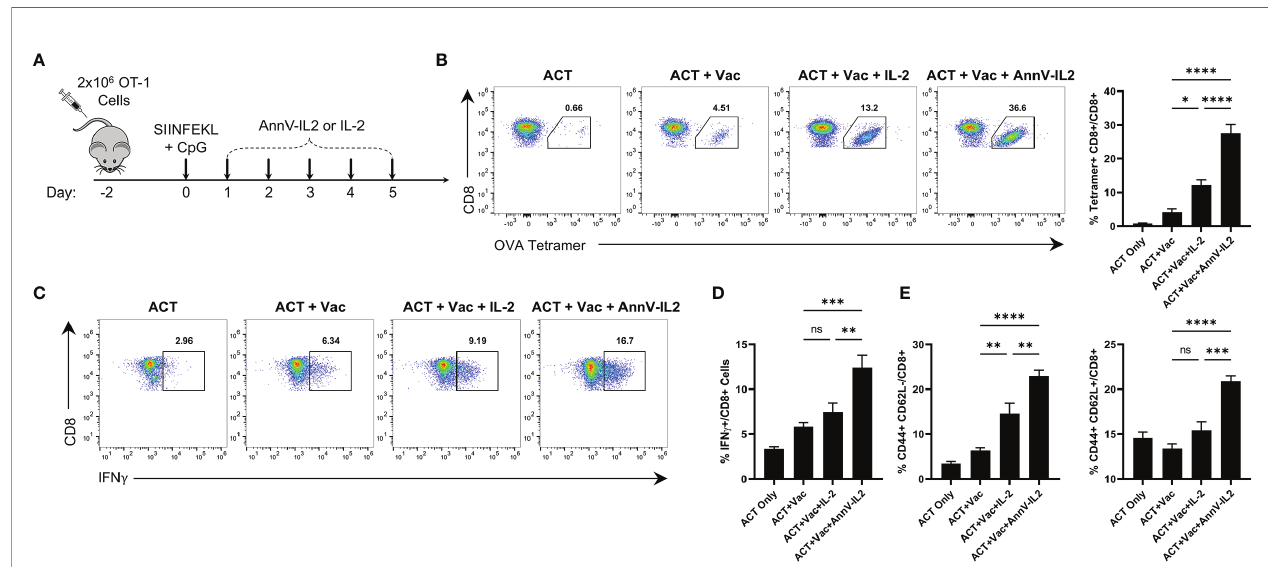
FIGURE 4 | AnnV-IL2 expands adoptively transferred cells in vivo . (A) Schematic of experimental design. Brie fl y, naive C57BL/6 mice received 2x106 OT-1 cells intravenously on day -2, followed by intraperitoneal injection of the peptide corresponding to the immunodominant epitope of OVA (OVA257-264, SIINFEKL) and TLR9 agonist, CpG, on day 0. Mice were treated with equimolar amounts of AnnV-IL2 or IL-2 intraperitoneally once daily for a total of 5 days. On day 8, peripheral blood mononuclear cells were collected by submandibular bleeding. Dots plots are representative of one mouse in each group. N=5 mice per group. (B) Antigen- speci fi c cells were quanti fi ed by tetramer staining. Bar chart depicts frequency of OVA257-264-specifc CD8+ T cells (C) PBMC ’ s were stimulated with PMA and ionomycin in the presence of Brefeldin A and Monensin for 2 hours and IFN g production was quanti fi ed by intracellular cytokine staining. Bar chart depicts IFN g + CD8+ T cells. (D) CD8+ effector memory (Teff) cells were quanti fi ed by fl ow cytometry at day 8 by expression of CD44 and CD62L. (E) CD8+ central memory (TCM) cells were quanti fi ed by fl ow cytometry at day 16 by expression of CD44 and CD62L. Data is represented by mean ± SEM. P values were calculated by ordinary one-way ANOVA with the Tukey Kramer multiple comparison test, and P < 0.05 is considered statistically signi fi cant. * = < 0.05, ** = < 0.01,*** = < 0.001, **** = < 0.0001. NS, not signi fi cant. OVA, Ovalbumin; TLR, Toll-like receptor; PBMC, peripheral blood mononuclear